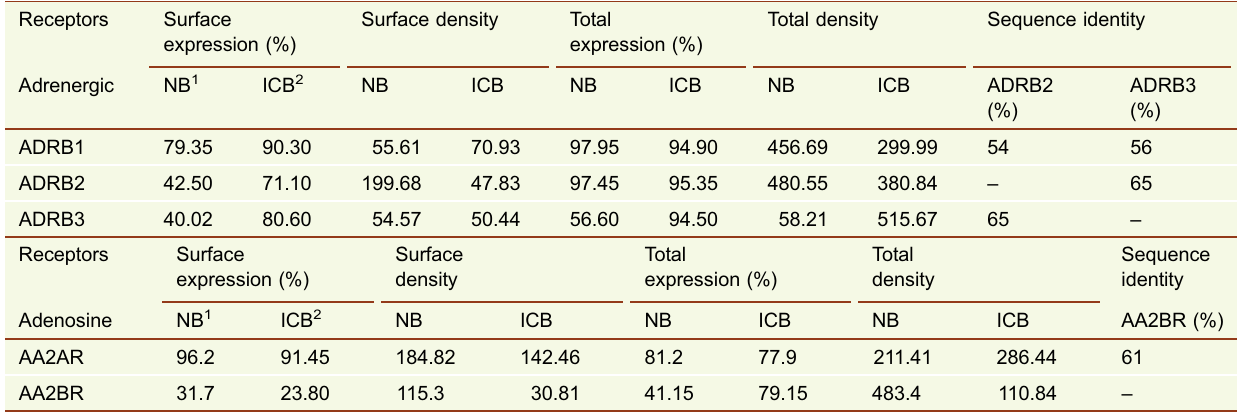
Table 7. Example of variance in expression despite high sequence similarity in the adrenergic and adensosine receptors within the Rhodopsin family Receptors Surface expression (%)